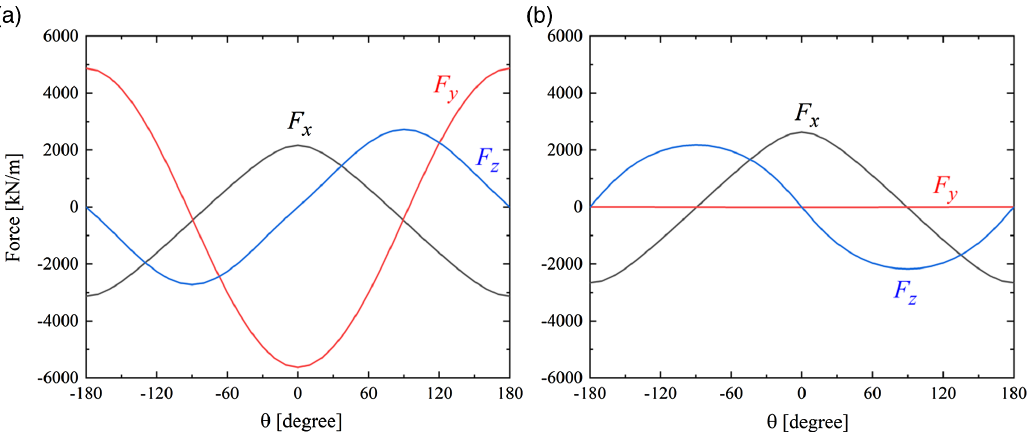
FIG. 2. Magnetic force of an APPLE undulator calculated as a function of the phase for two different gap values of (a) 2 mm and (b) 20